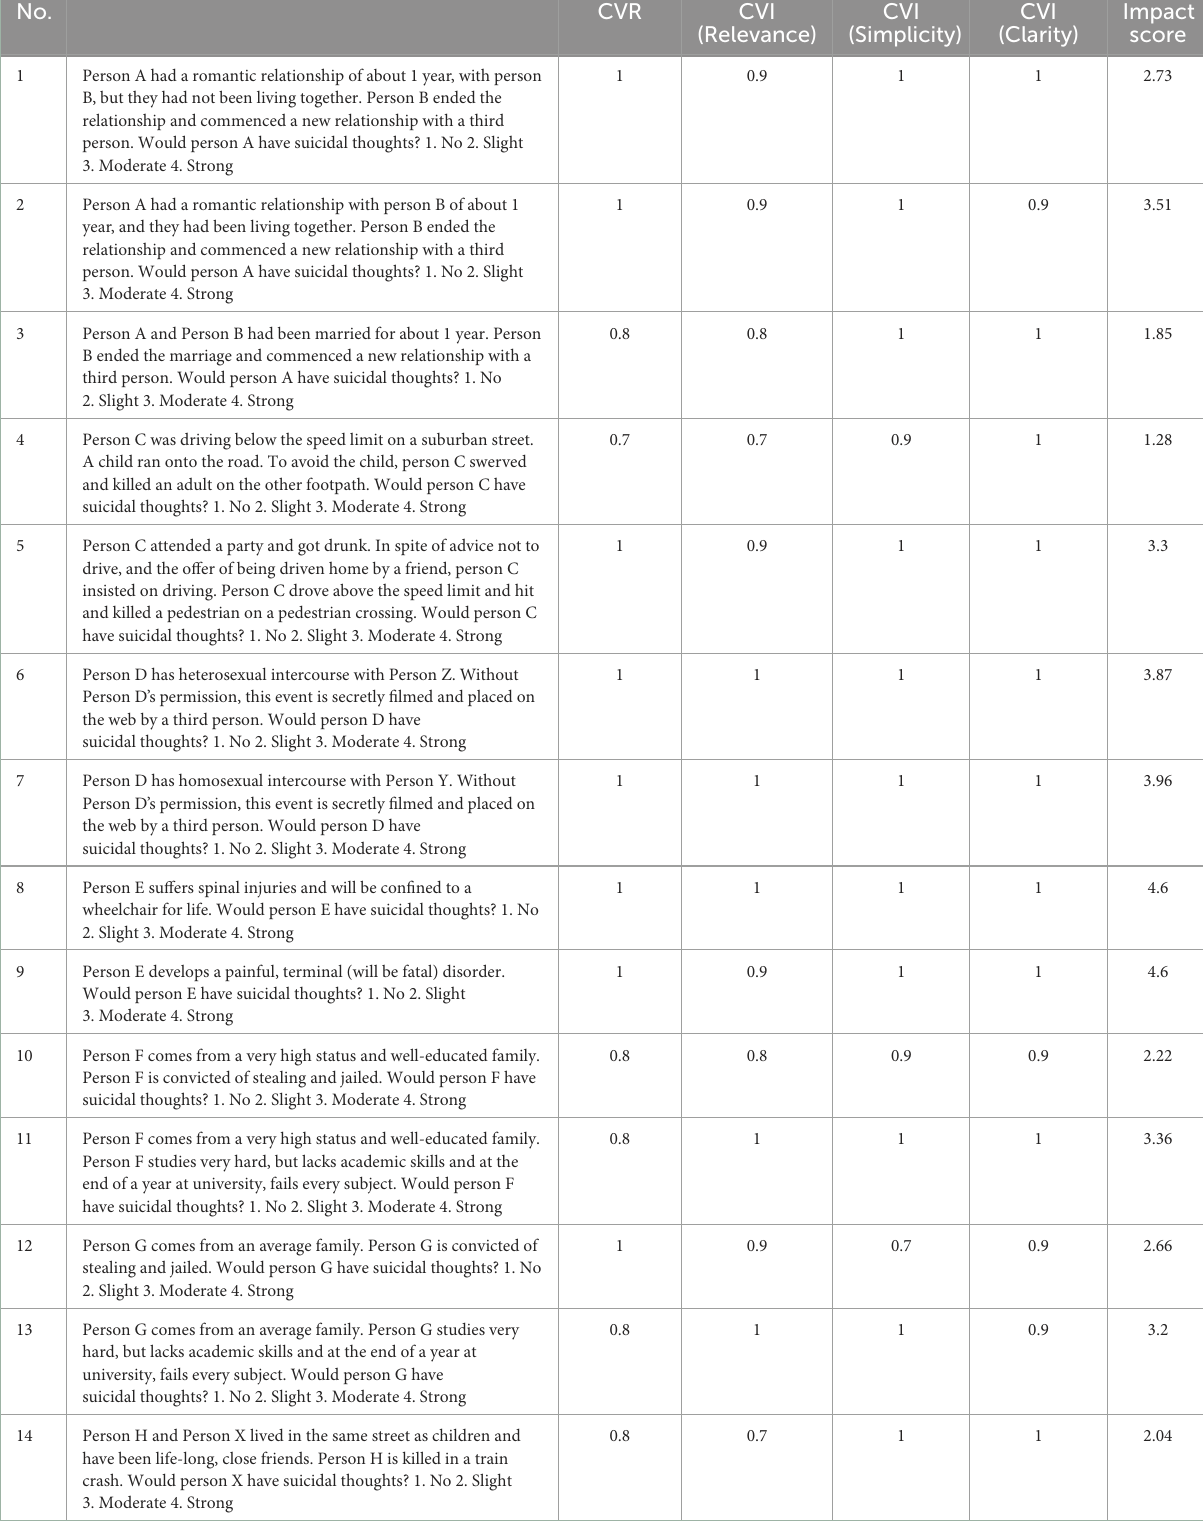
TABLE 3 Validity results in the Persian version of the predicaments questionnaire. No.